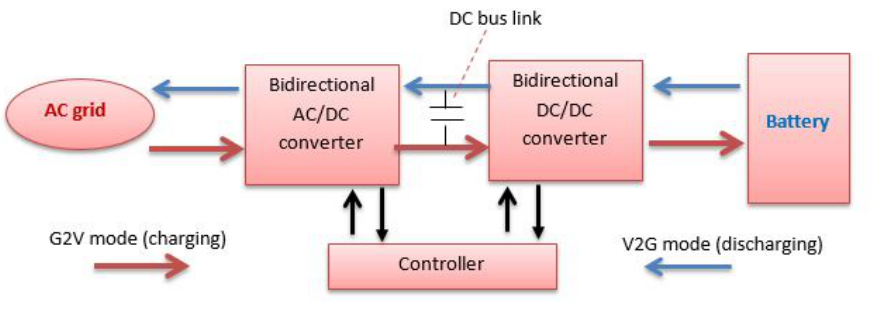
Figure 1. EV bidirectional charger